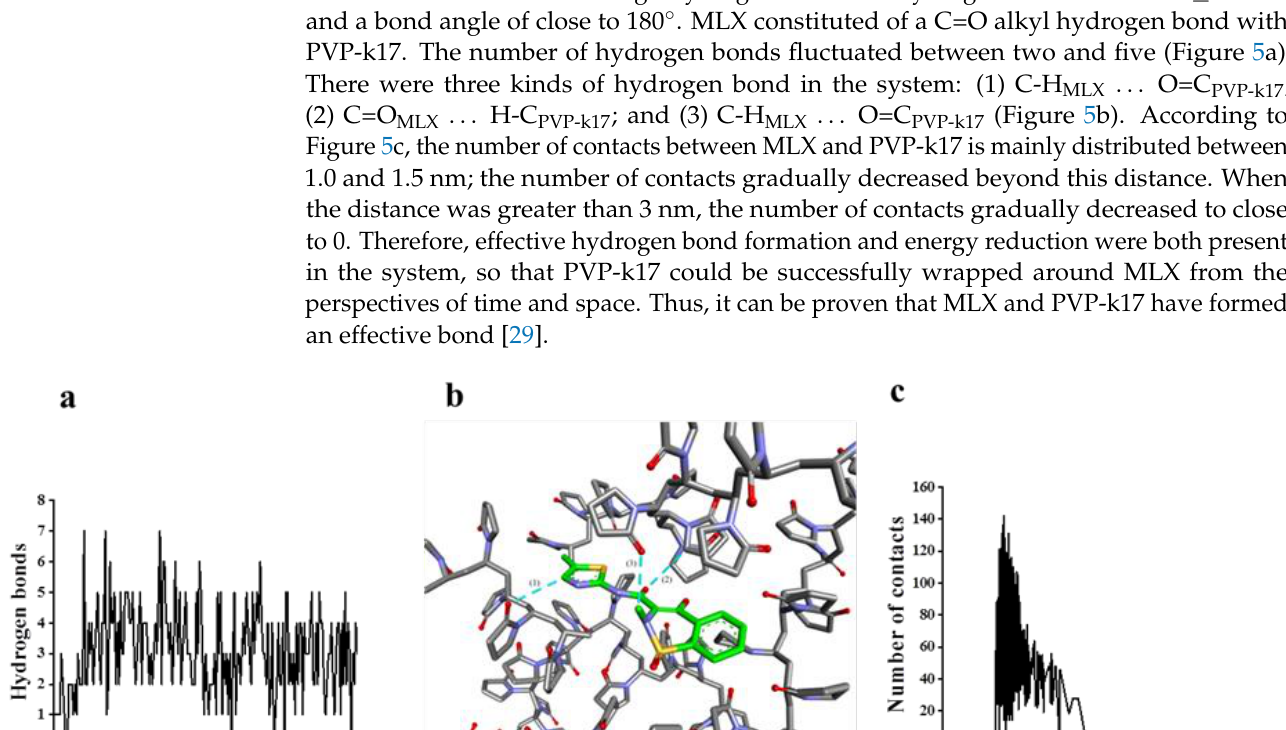
Figure 4. ( a ) The distribution of MLX (green sticks) and PVP-k17 (gray sticks) in the water, hydro- phobic interaction (yellow sticks), and hydrogen bonds (light blue sticks); ( b ) the van der Waals energy, electrostatic energy, and interaction energy between MLX and PVP-k17.